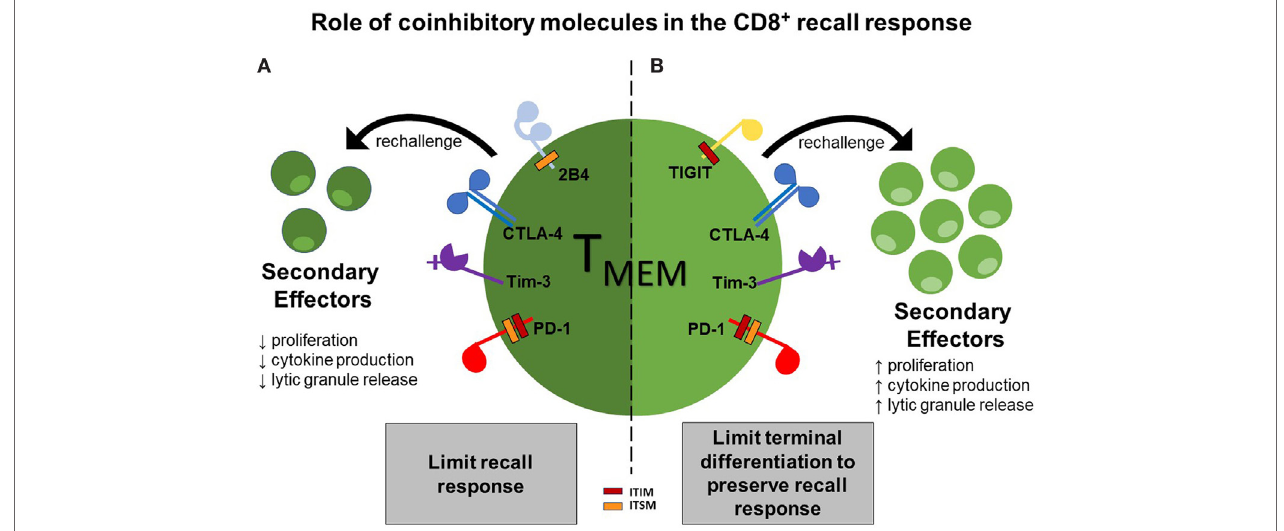
FigURe 1 | Two functions of coinhibitory molecules in modulating the CD8 + recall response. Functionality of CD8 + T cell secondary effectors can be limited by ligation of the coinhibitory molecules 2B4, CTLA-4, Tim-3, and programmed-death 1 (PD-1), thus dampening the recall response (A) ; however, ligation of the coinhibitory molecules TIGIT, Tim-3, CTLA-4, and PD-1 can function to preserve secondary recall responses by inhibiting terminal differentiation, thus leading to a more stable memory population (B)